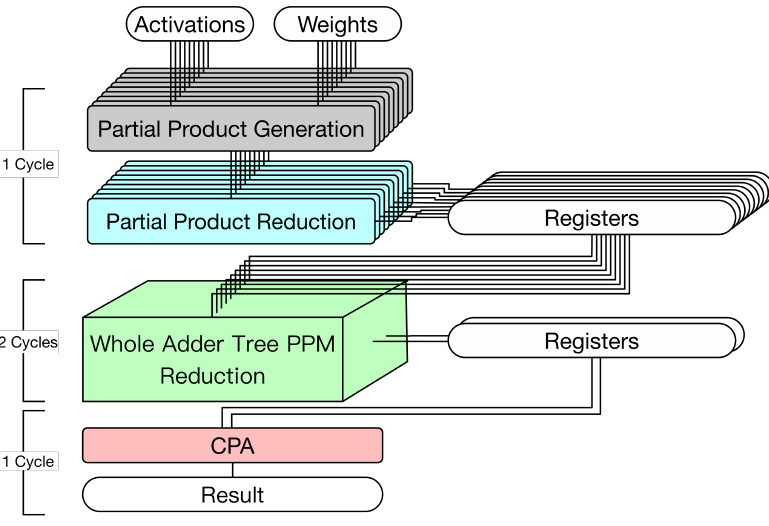
Figure 5. The proposed hardware circuit implementation for the 3 × 3